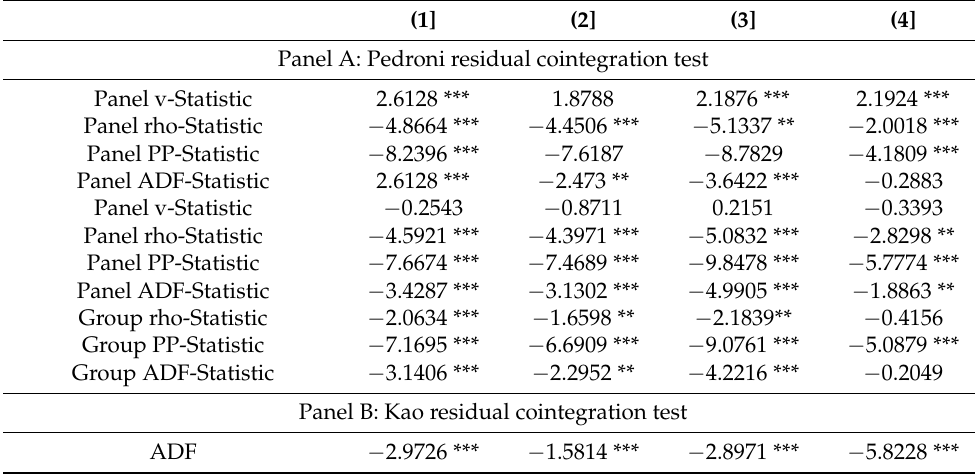
Table 9. Results of panel cointegration.